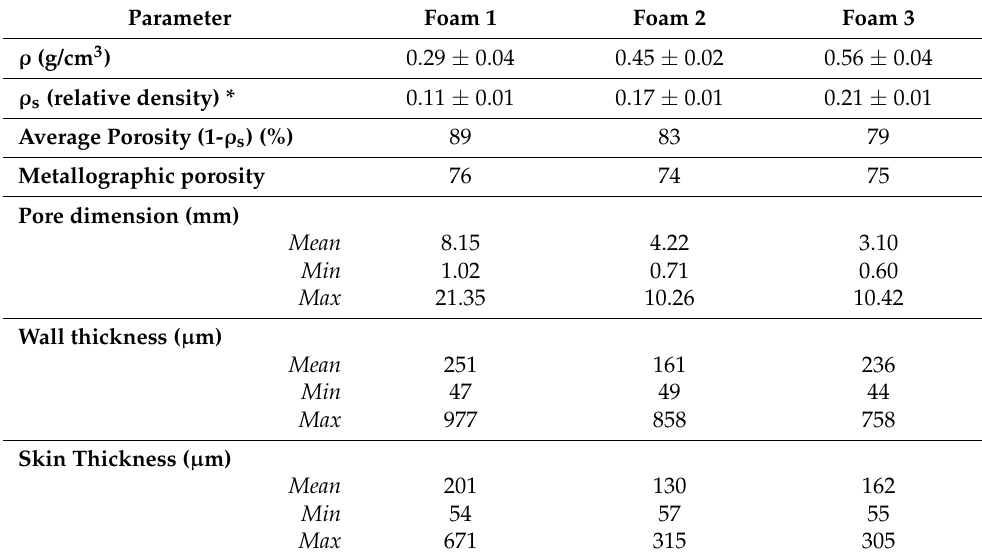
Table 1. Density, porosity, pore dimension, and skin and cell wall thickness of the Cymat-type foams.